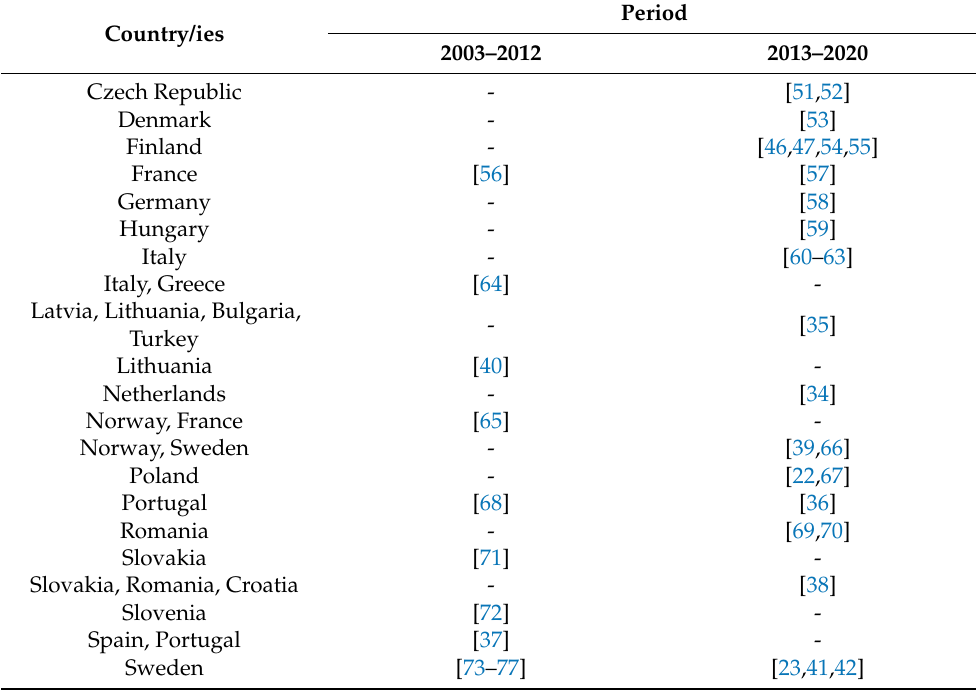
Table 1. List of publications used in the meta-analysis divided by period and